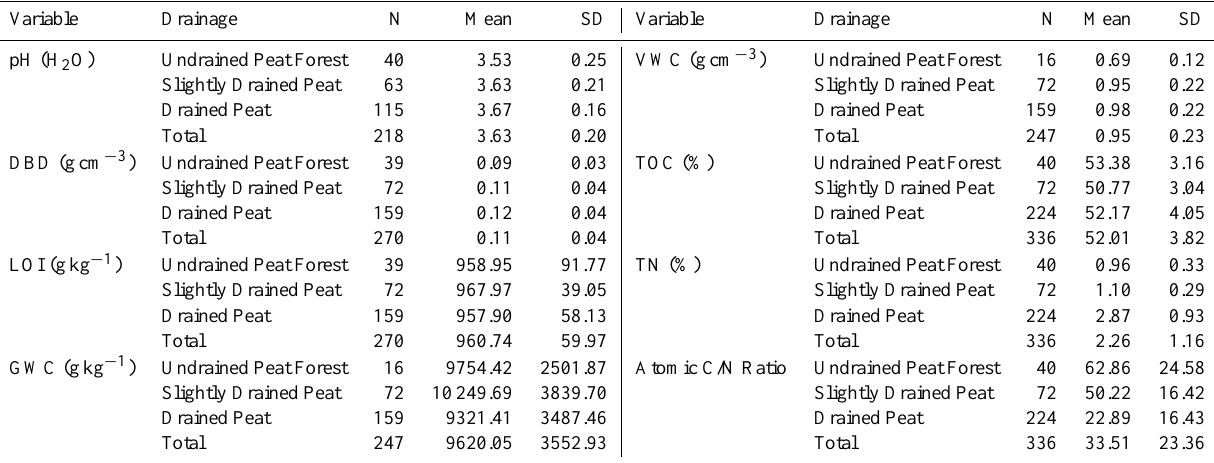
Table 8. Means of Research Variables in Drainage Groups.